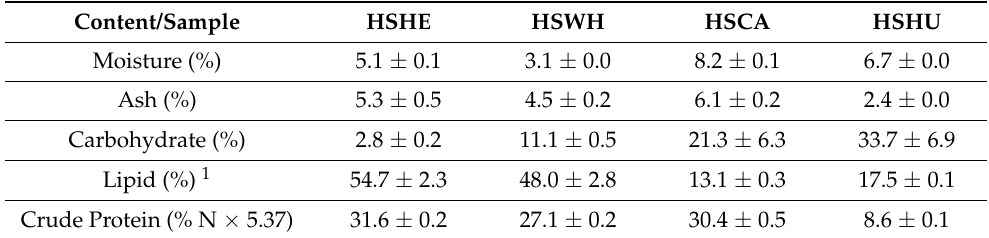
Table 1. Moisture, ash, carbohydrate, and protein content of hemp hearts, whole seeds, hemp cake, and hemp seed